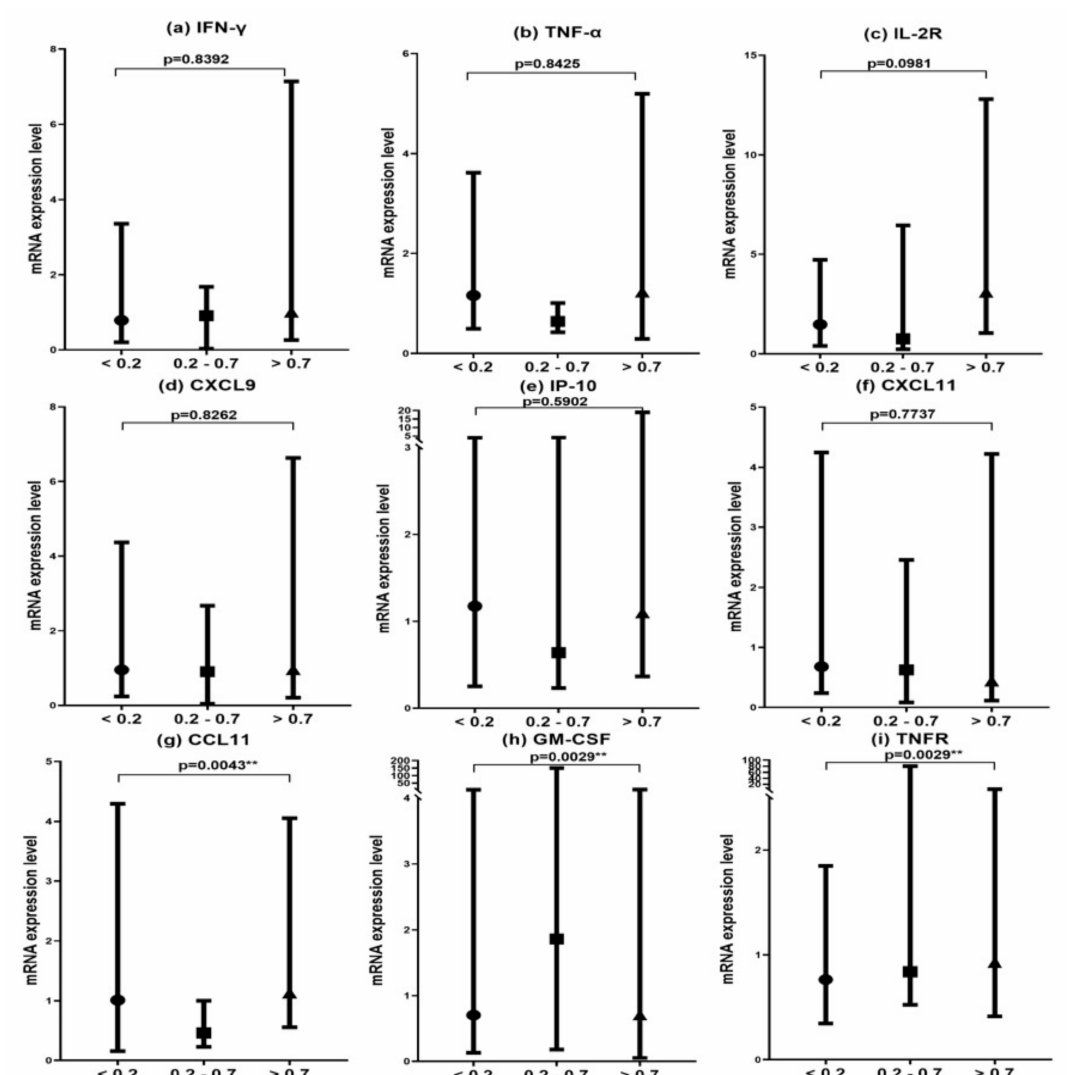
Figure 2. Target gene mRNA expression levels after stimulation of Mycobacterium tuberculosis (MTB)-specific antigens for 24 h according to QuantiFERON-TB Gold In-Tube (QFT-GIT) response groups. Note: Whole blood of study subjects (<0.2 IU/mL QFT-GIT response group, 0.2–0.7 IU/mL QFT-GIT response group, and >0.7 IU/mL QFT-IT response group) was stimulated with MTB-specific antigens (early secretory antigen target 6, culture filtrate protein 10, and TB 7.7) for 24 h and the mRNA expression levels for target genes were analyzed by real-time RT-PCR. The graphs represented median ± SD value ( (cid:4) , HD/normal; • , HD/LTBI; (cid:78) , HC) ( a ) interferon (IFN)- γ , ( b ) tumor necrosis factor- α (TNF- α ), ( c ) IL-2R, ( d ) CXCL9, ( e ) IFN- γ - induced protein 10 (IP-10), ( f ) CXCL11, ( g ) CCL11, ( h ) granulocyte-macrophage-colony stimulating factor (GM-CSF), and ( i ) TNF receptor (TNFR). ** p <